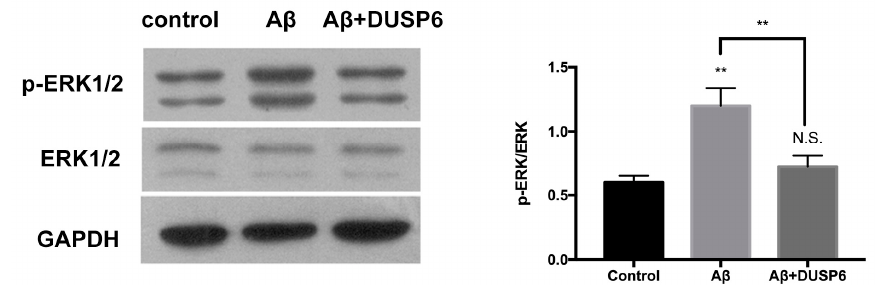
Figure 5. The effect of A β 25–35 and DUSP6 overexpression on ERK1/2 activation in NSCs. NSCs were transfected with the DUSP6 overexpression plasmid. After transfection for 24 h, each group of cells was treated with A β 25–35 for 24 h and harvested for Western blotting. N.S.: p > 0.05, **: p < 0.01 vs. control. **: p < 0.01 vs. the A β -treated group. n = 3.